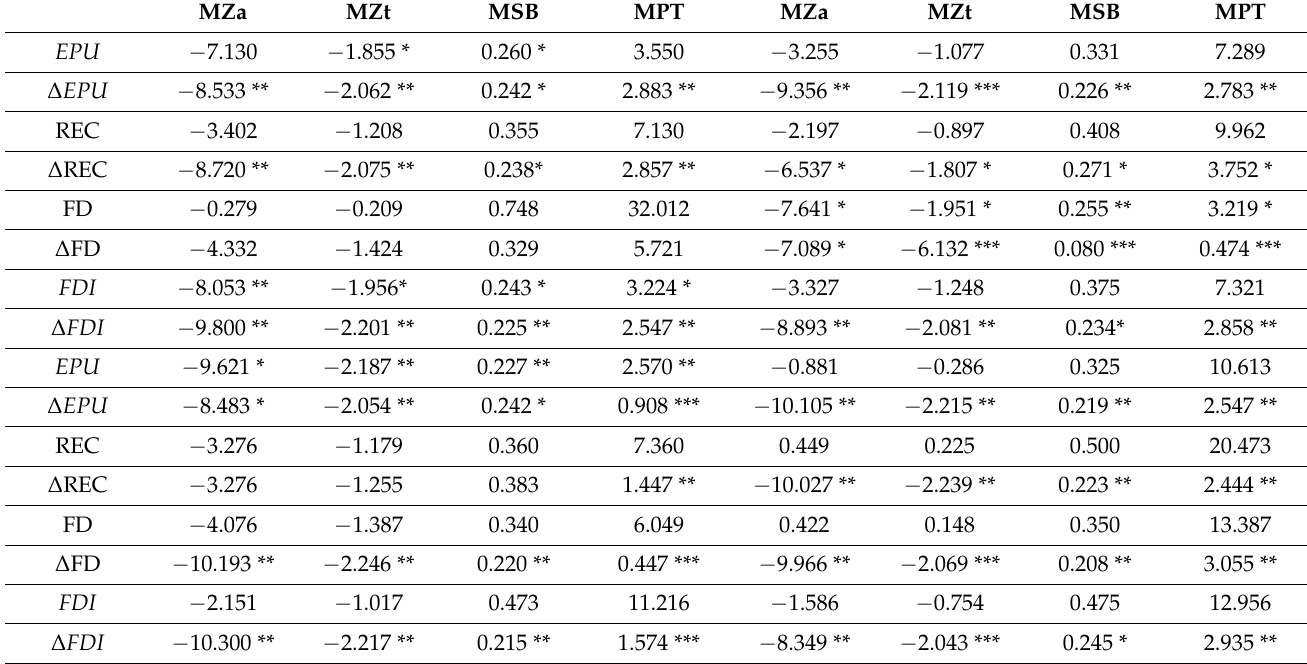
Table 4. Results of Ng–Perron unit root test.